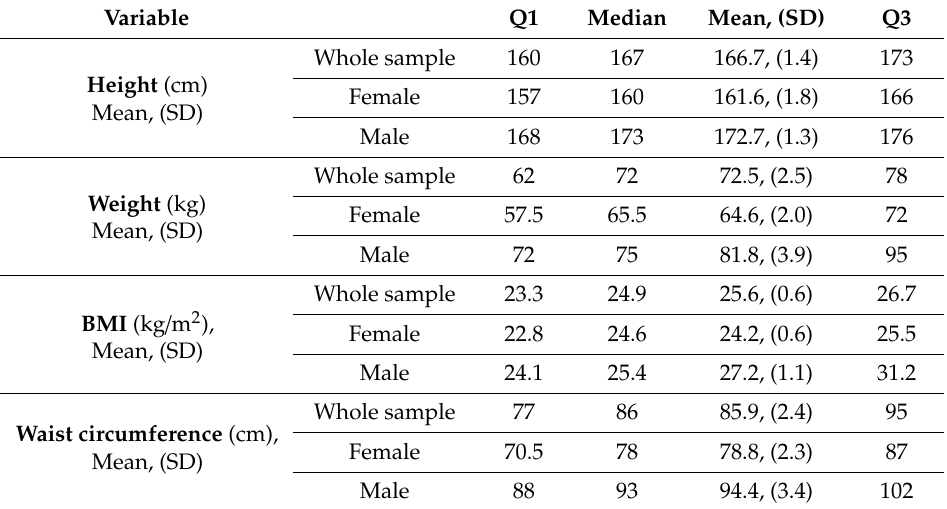
Table 2. Anthropometric results.